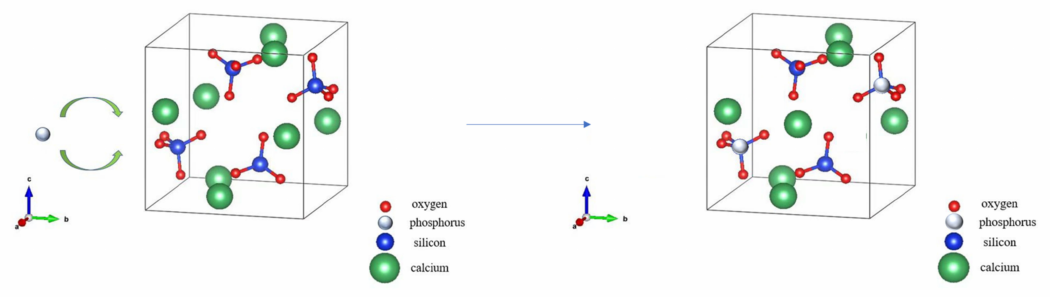
Figure 8. Schematic diagram of P participating in the structure of dicalcium silicate (C 2 S) in the phosphorous